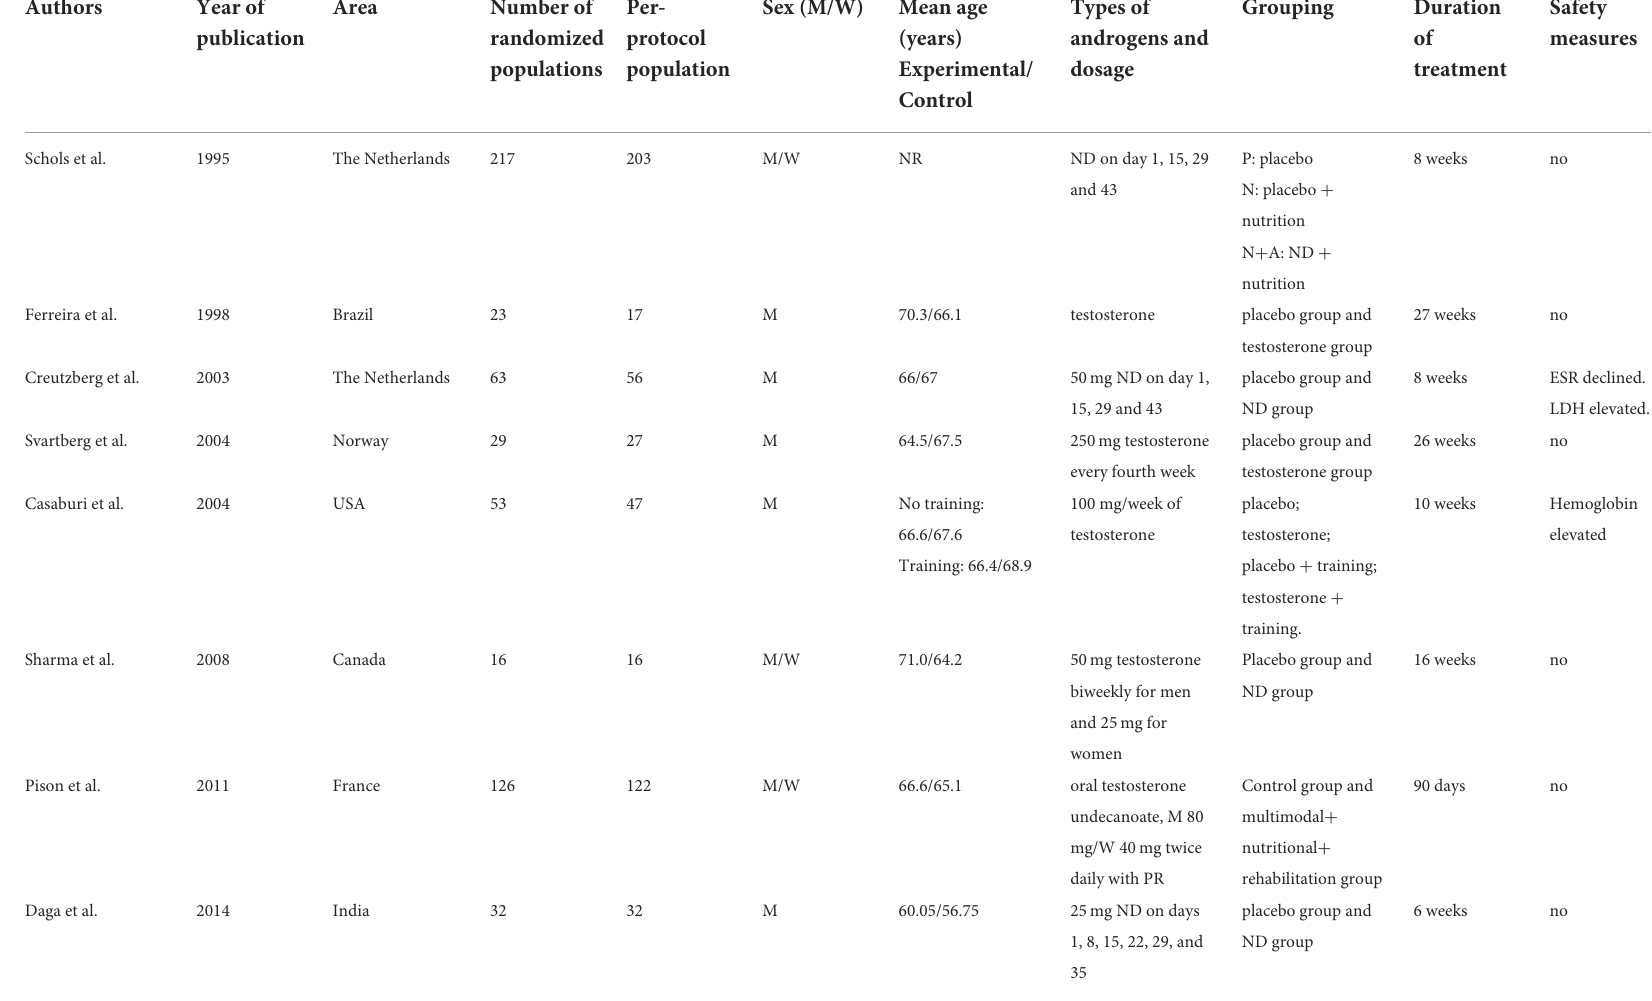
TABLE 1 Selected characteristics of the eight RCTs included in this systematic